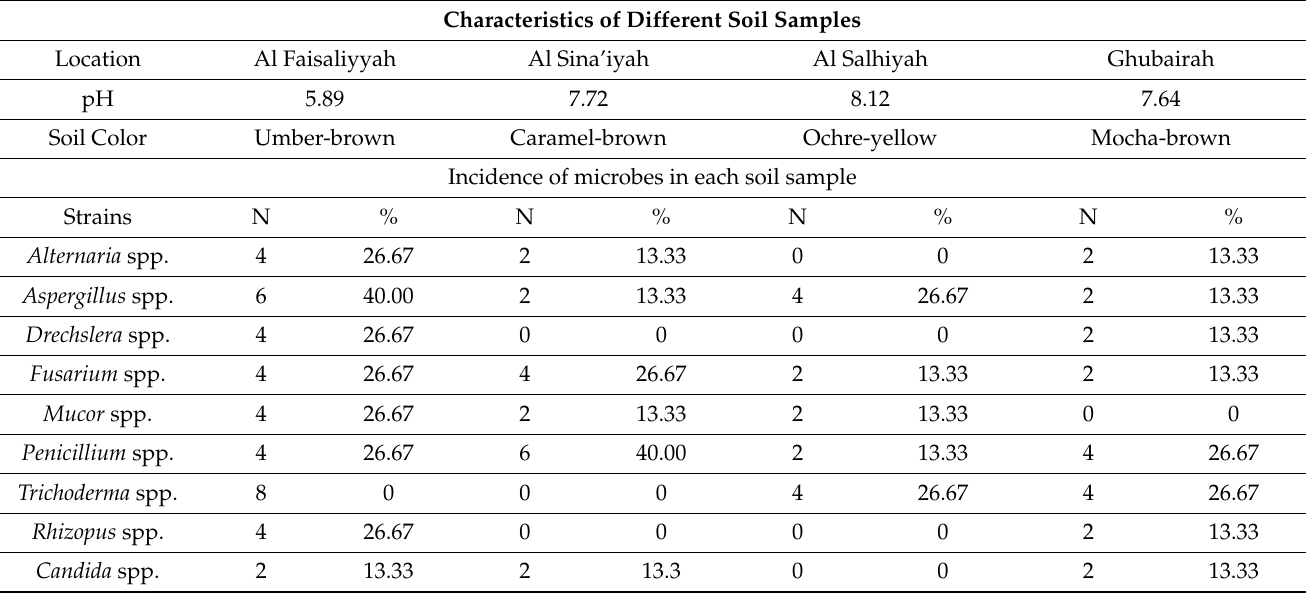
Table 1. Frequency of isolated and identified fungi in each soil sample. Characteristics of Different Soil